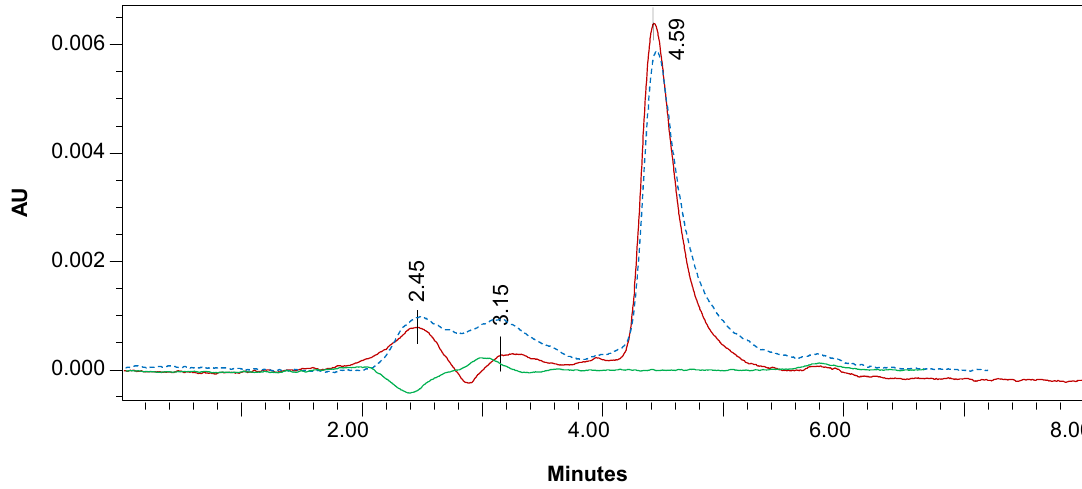
Figure 4. Typical HILIC chromatograms of a blank sample (green line) overlaid with a 3.5 μg mL −1 risedronate standard solution (red line) and a solution obtained from the analysis of risedronate commercial tablets (blue line). Chromatographic conditions: ZIC®-pHILIC analytical column, mobile